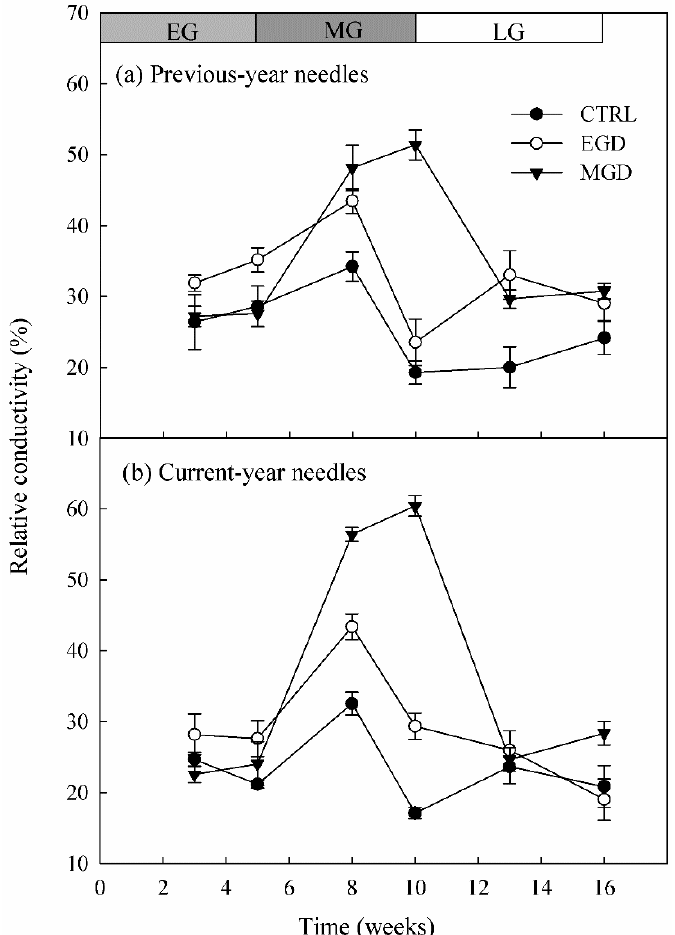
Figure 4. Electrolyte leakage in the previous-year ( a ) and current-year ( b ) needles of Mongolian pine saplings by treatment. CTRL indicates the control. EGD and MGD indicate drought stress treatment in the early- (EG) and mid- (MG) growing seasons, respectively. EG, MG and LG refer to the early- (weeks 1–5), mid- (weeks 6–10) and late- (weeks 11–16) growing season, respectively. Time indicates weeks from the beginning of the experiment. Bars indicate standard error ( n = 4).